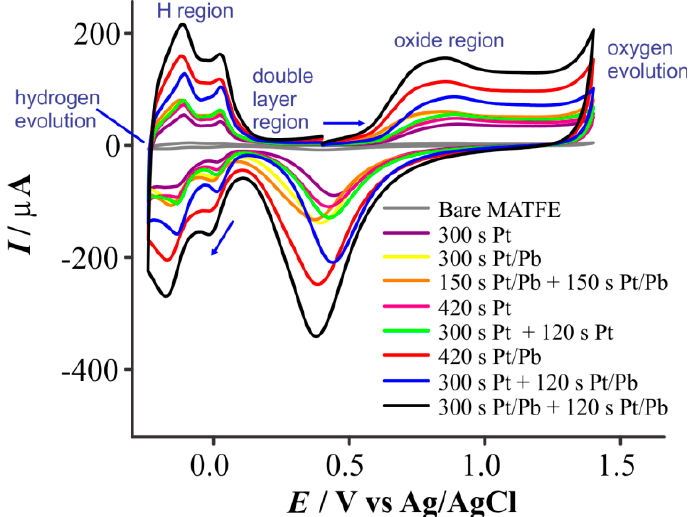
Figure 3. Cyclic voltammograms (10th cycle, 500 mVs − 1 ) recorded on the different MATFEs between +1.4 and − 0.24 V in a N 2 -saturated solution of 0.5 M H 2 SO 4 . The integrated area ( Q = I × t ) of the H 2 desorption peaks (background subtracted) was used to calculate the electroactive surface area (ESA).